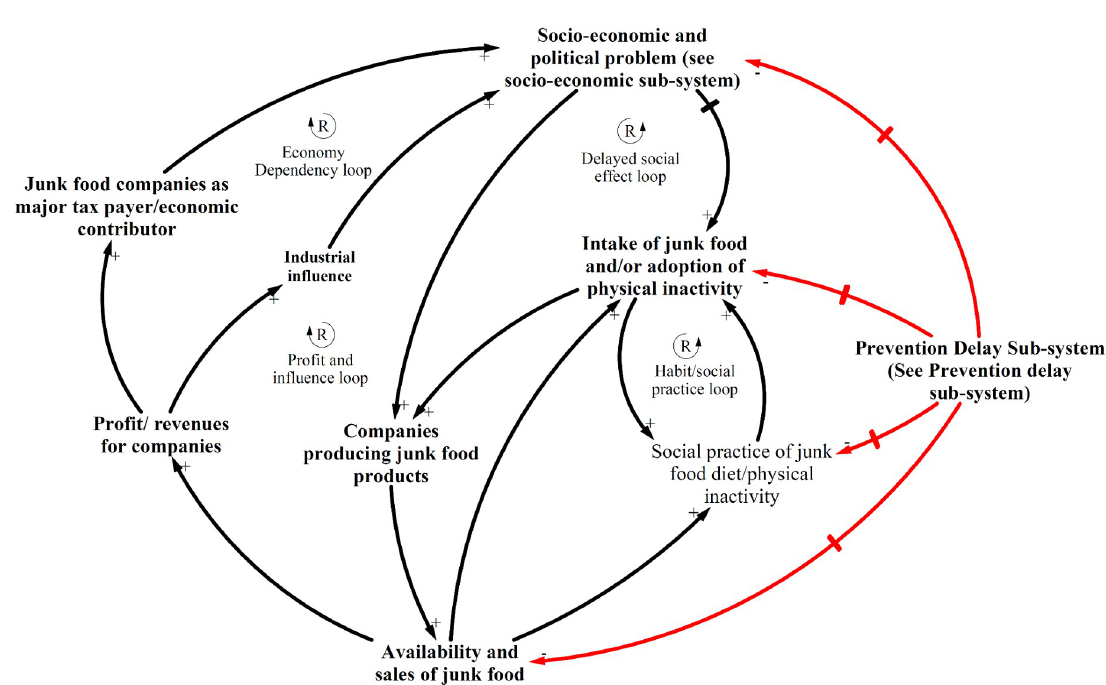
Fig 4. Demand-supply sub-system showing the interaction of availability and sales of junk food, other sub-systems and NCDs.